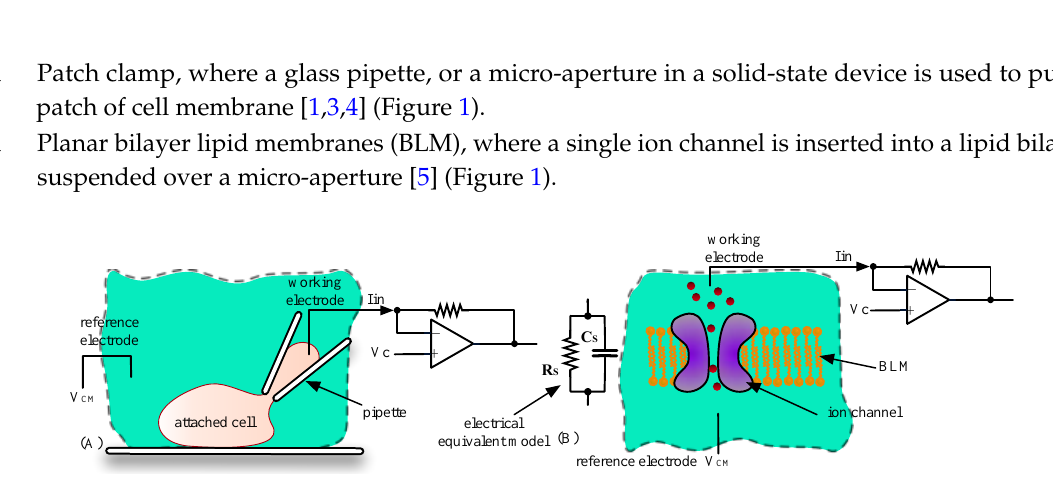
Figure 1. ( A ) Diagram showing the patch clamp technique where a glass pipette is used to pull a patch of cell membrane. A low-noise transimpedance amplifier measures channel currents; ( B ) the planar bilayer membrane (BLM) technique where a suspended lipid bilayer contains an ion-channel. Again the current is read by a low-noise transimpedance amplifier. The picture also shows the electrical equivalent model of the BLM, consisting of a high value resistor (of the order of GΩ or greater) in parallel with a capacitance C S .